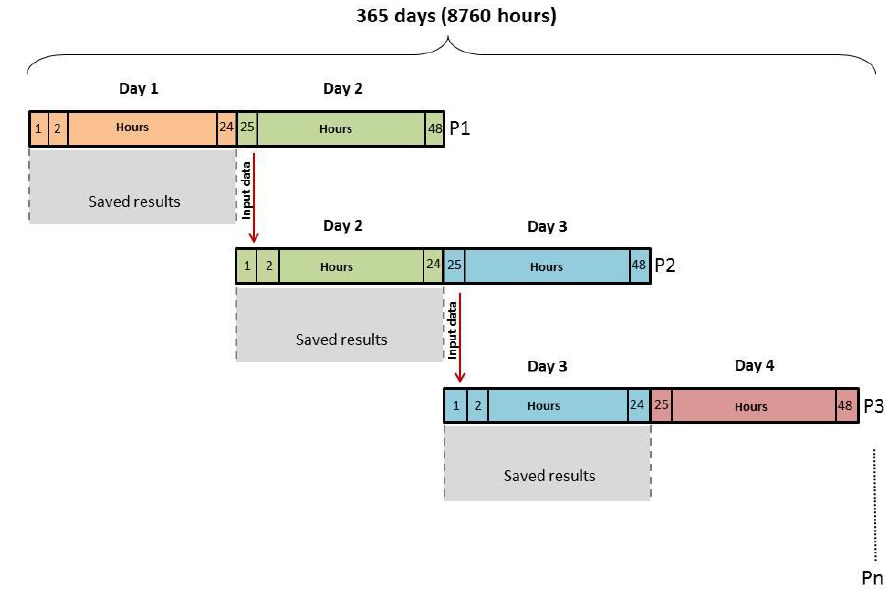
Figure 2. Illustration of the stepwise model solving.